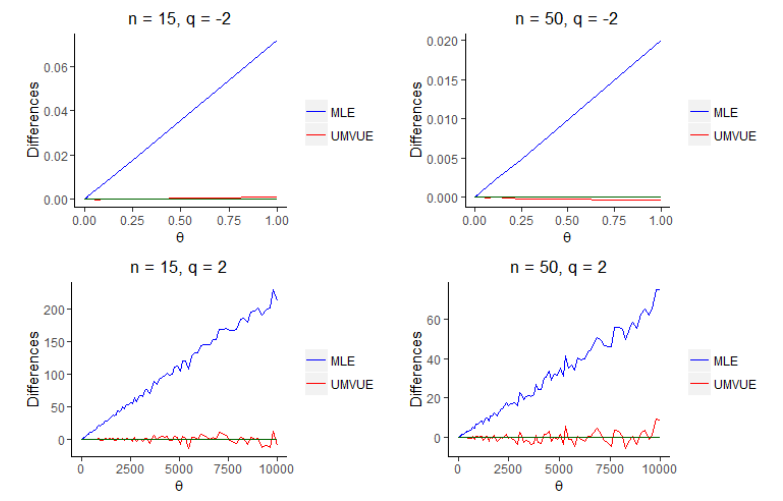
Figure 2 – Estimated bias of the UMVUE and MLE of θ q for different sample sizes and values of q .